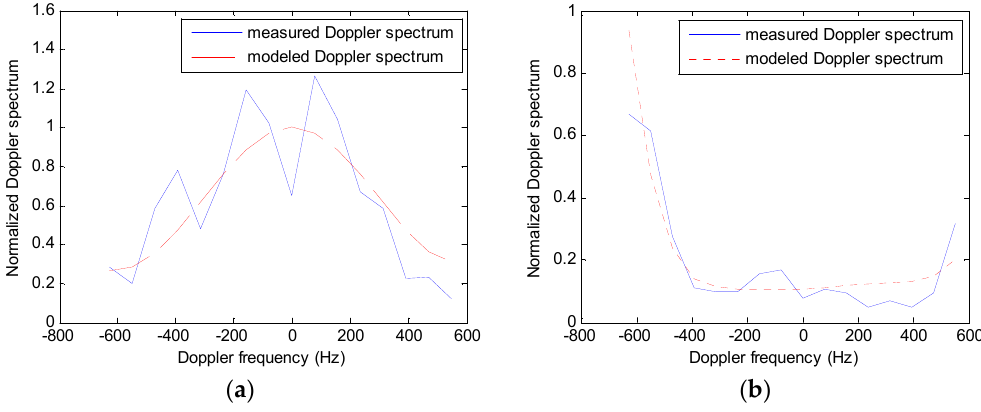
Figure 12. ( a ) Doppler spectrum of point A in Figure 11a; ( b ) Doppler spectrum of point B in Figure 11b; Blue solid and red dashed lines are the measured and modeled Doppler spectra, respectively.